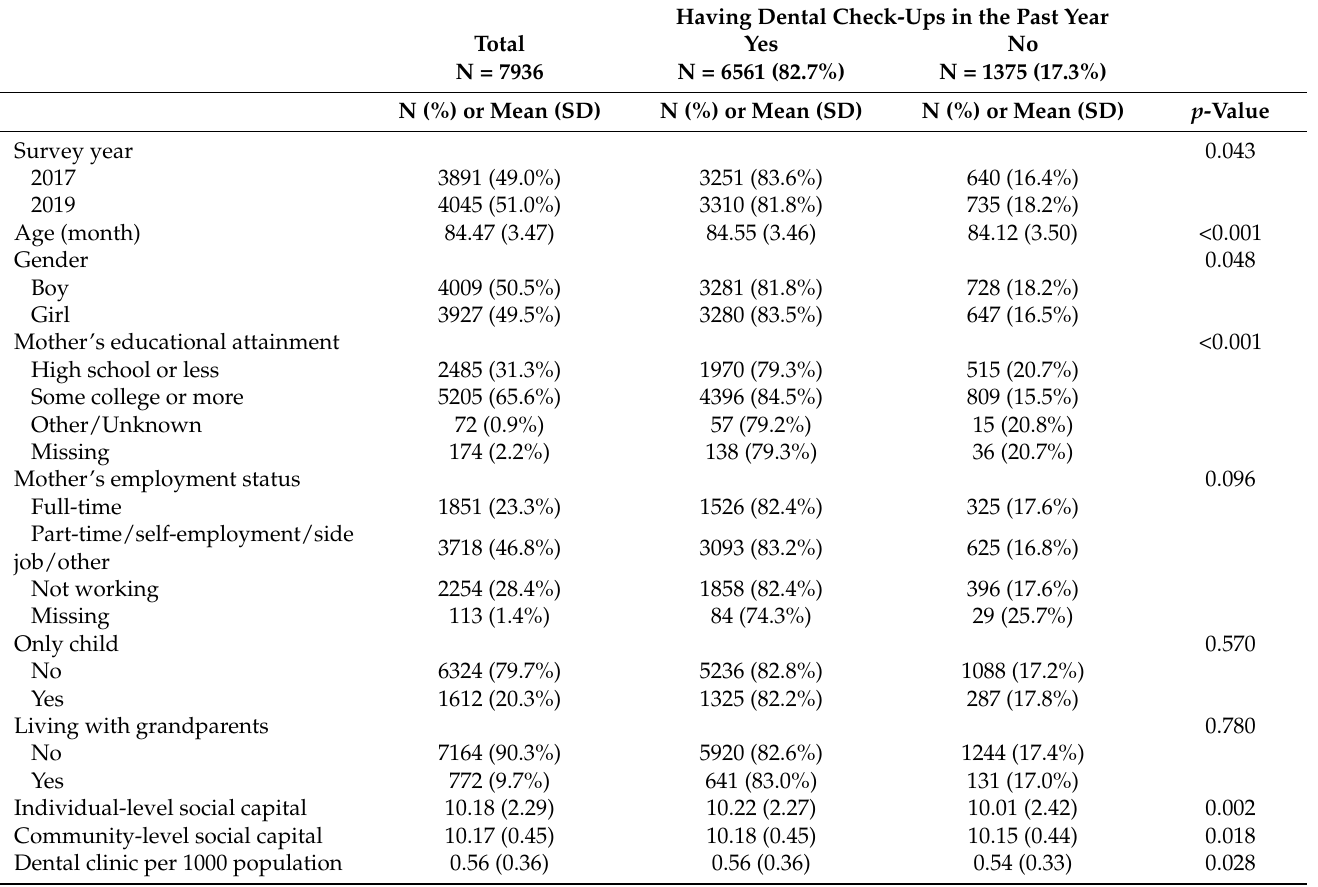
Table 1. Demographic characteristics of study participants (N =